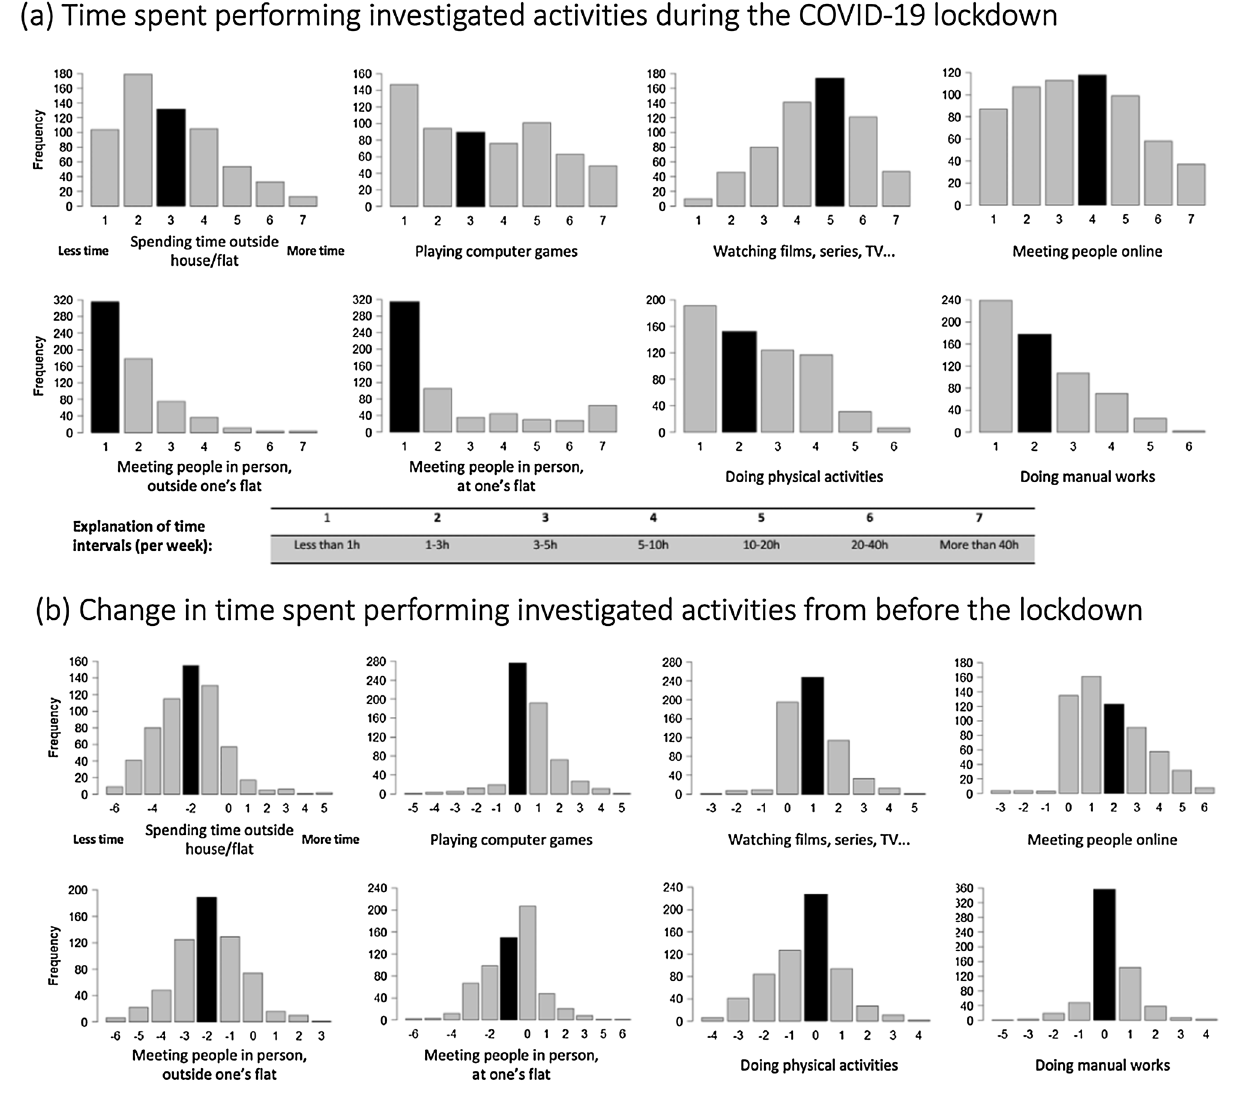
Figure 1. Histograms displaying distribution of weekly time spent performing investigated activities during lockdown (top panels) and the change in time spent doing these activities between lockdown and before the COVID-19 pandemic started (bottom panels). The change in time spent is indicated in the number of categories that changed—negative values indicate spending less time on a given activity during the lockdown than before, and positive values the opposite. Black bars indicate median